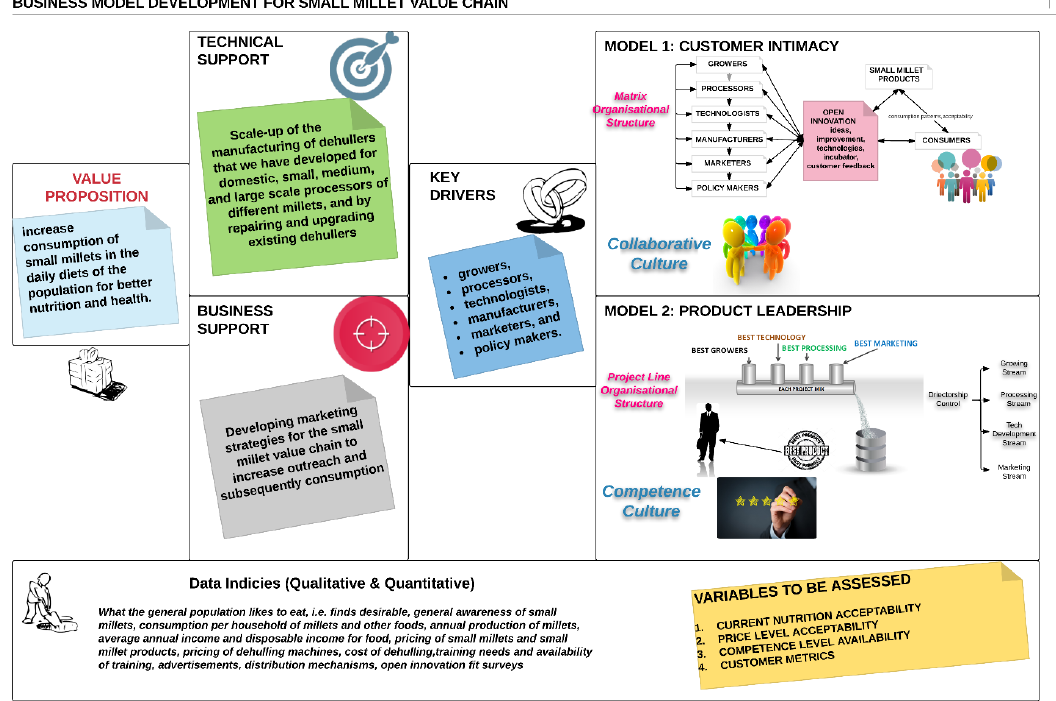
Figure 5. Business model development canvas for the small millets value chain.